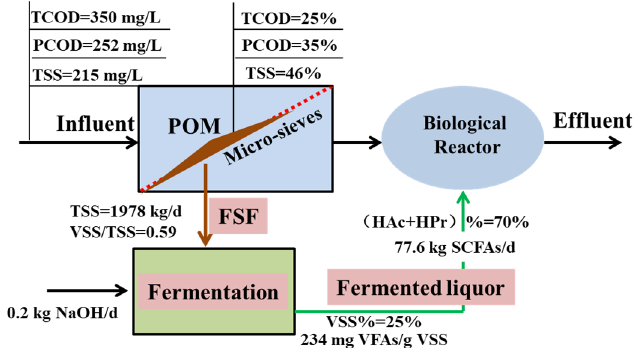
Figure 5. Preliminary evaluation of carbon conversion by FSF recovery and fermentation under alkaline condition. Table 3. Preliminary evaluation of the environmental benefits of FSF under alkaline condition.